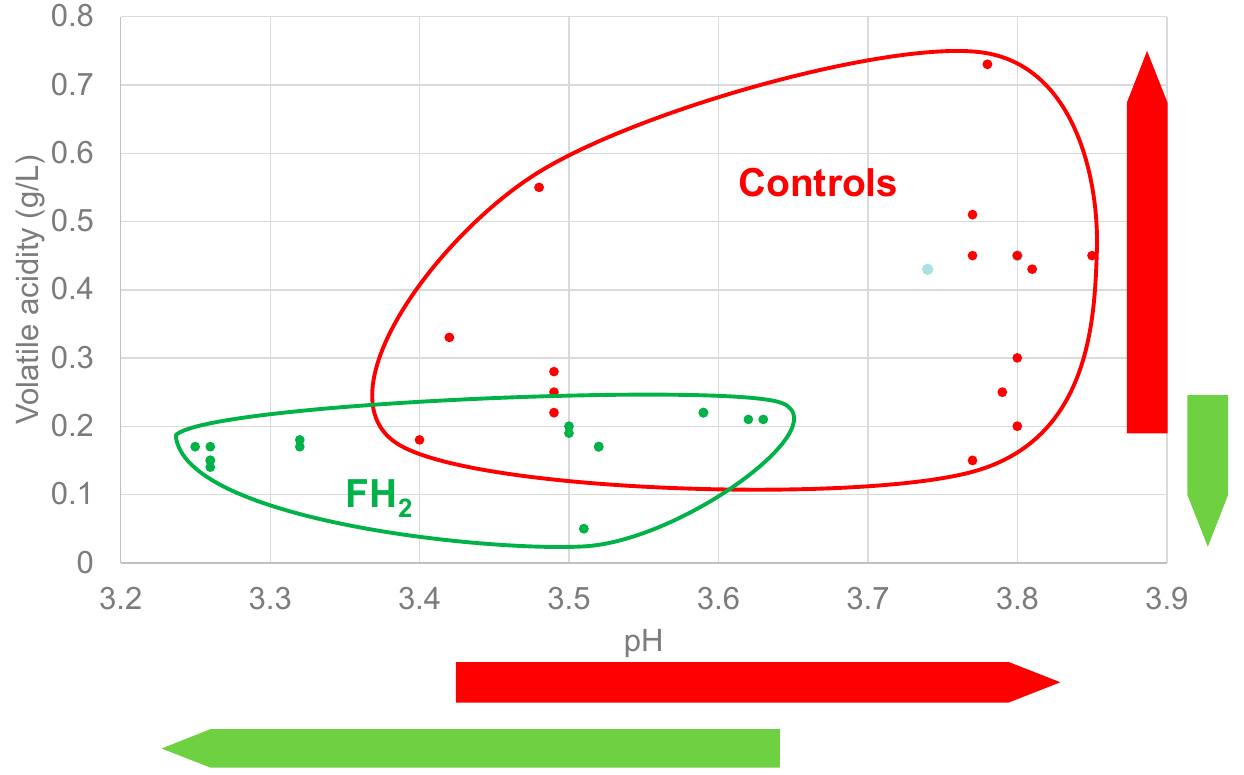
Figure 4. Values of volatile acidity and pH in all trials (years 2018, 2020, and 2021) of controls inoculated or with spontaneous fermentation and treatments with MLF inhibited by FH2.